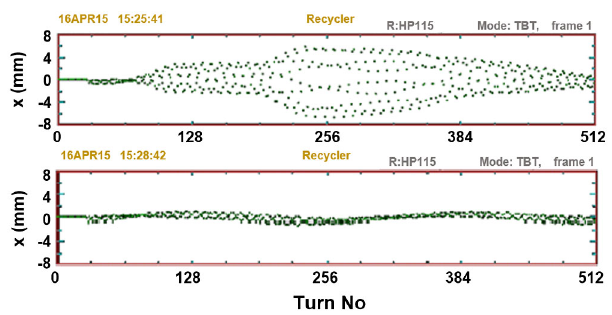
FIG. 6. Without the clearing bunch the beam of 3 . 6 × 10 12 p blows up in about 20 turns (top); with the clearing bunch of 1 × 10 10 p it remains stable (bottom). Turn-by-turn measurement of the horizontal position of the beam center.